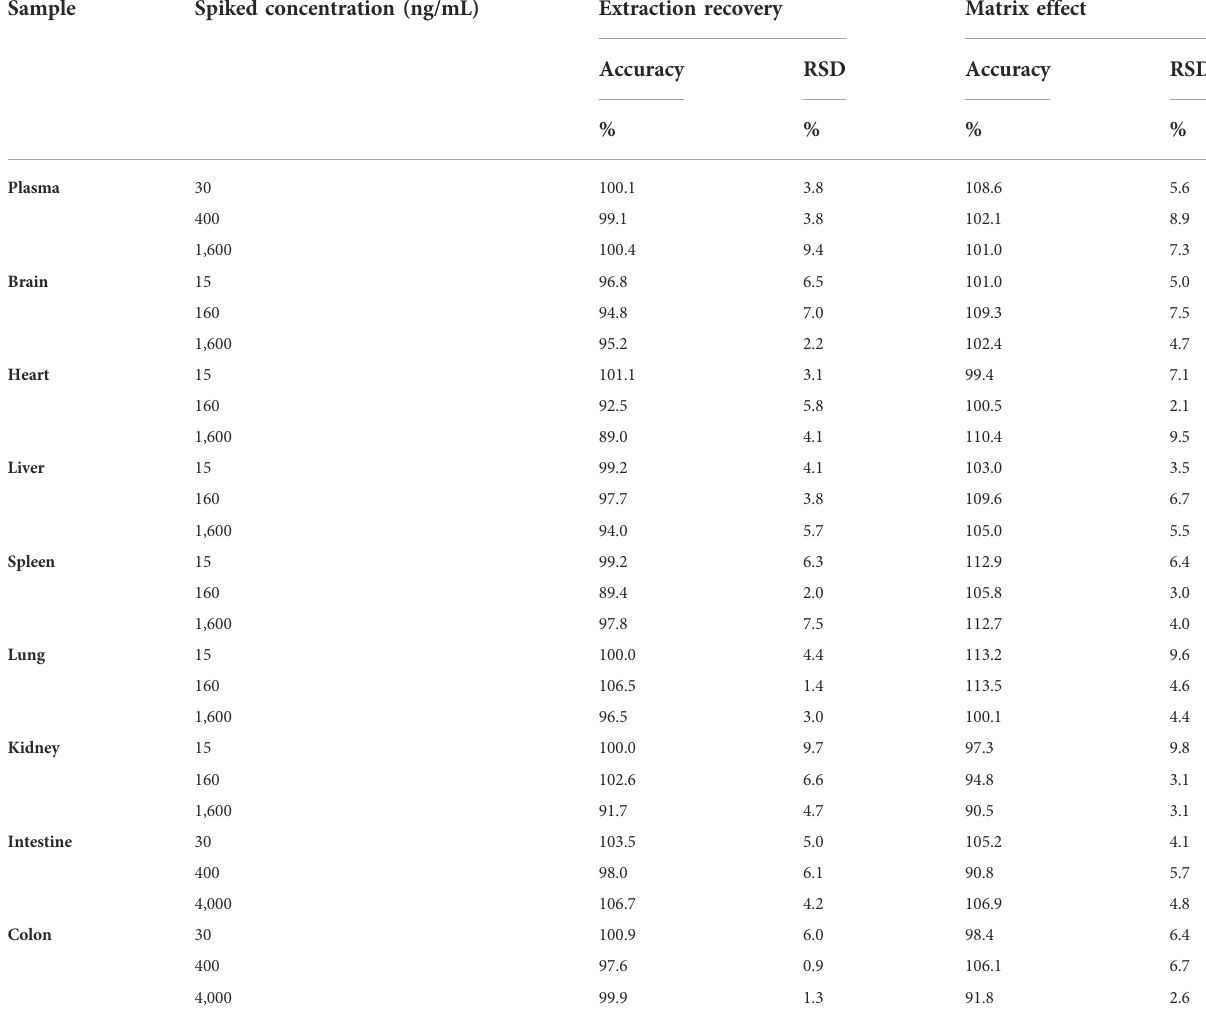
TABLE 3 The extraction recovery and the matrix effect of curcumol in rat plasma and tissue homogenates (n = 5). Sample Spiked concentration